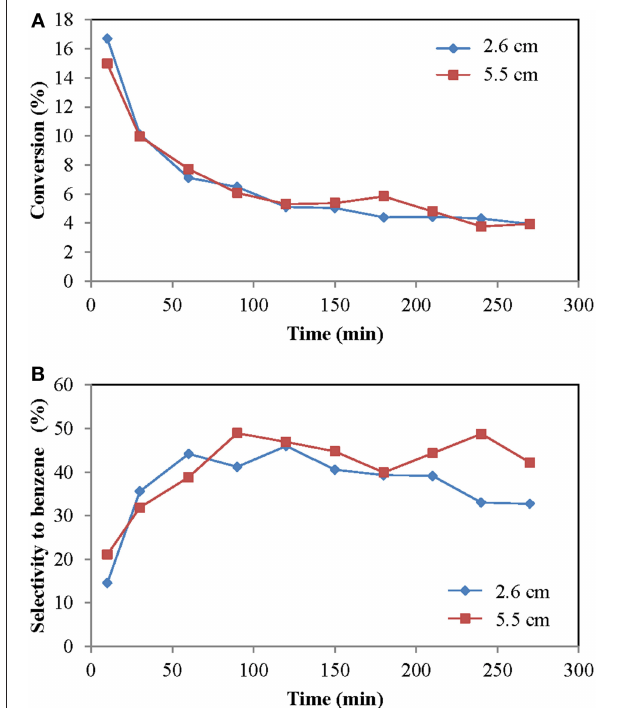
FIGURE 5 | Influence of the variation of the feed flow (time on stream time). (A) Methane conversion, (B) Selectivity to benzene. Operating conditions: W cat = 12g, CH 4 :O 2 :N 2 = 70:1.5:28.5 and T = 700 ◦ C.